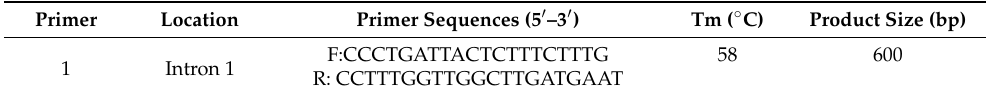
Table 1. Used PCR amplification primers in g.112558859 A > G locus of Dezhou donkey. Primer Location Primer Sequences (5 (cid:48) –3 (cid:48)